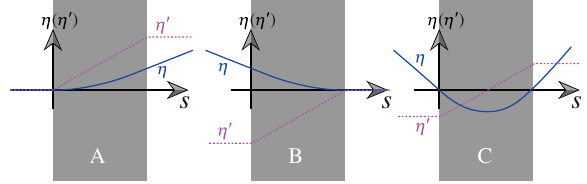
FIG. 1. Three kinds of dipoles based on the entrance dispersion. Each kind has a different contribution to ϵ z and a different optimization strategy. A: η 0 ¼ η 0 0 ¼ 0 ; B: achromatic dipole,